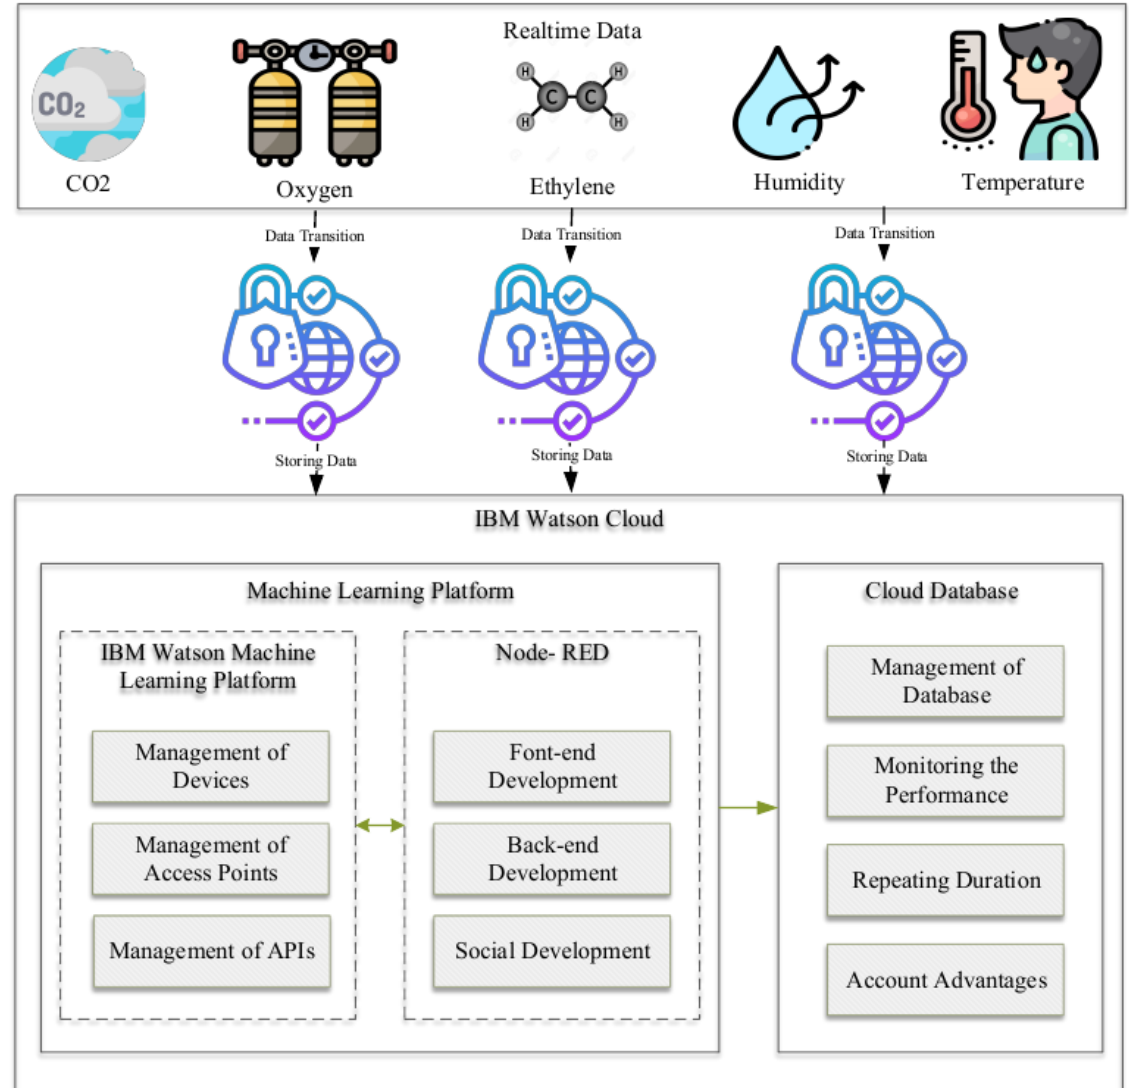
Figure 3. Process Flow of the IBM Watson Machine Learning Platform and IBM